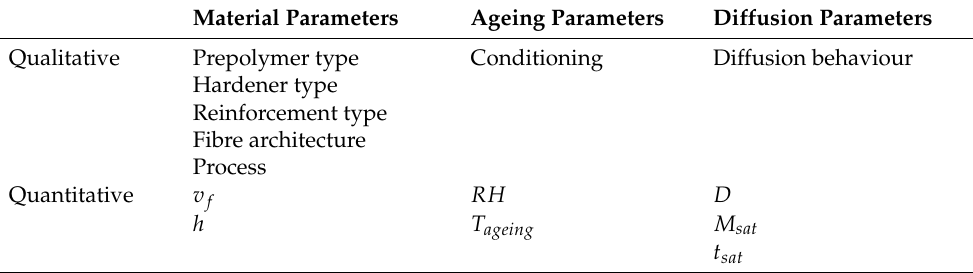
Table 1. List of variables used for the dispersion